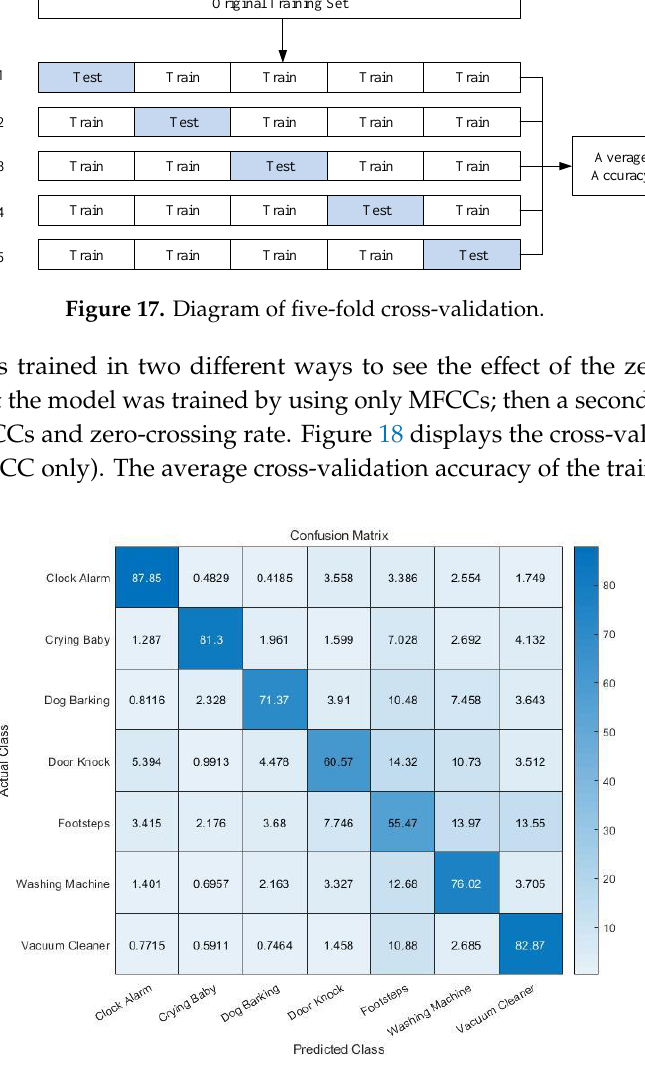
Figure 19. Five-fold cross-validation accuracy (MFCC + zero-crossing rate). A test was conducted after training a classifier. As a test set, the sound samples of the seven classes were primarily collected from YouTube. Then, the actual output sound underwent our hardware system to contain hardware dependent features. For the clock alarm sound, due to the lack of appropriate samples on YouTube, some were manually recorded. The collected sound clips were resized into 5 s long clips using a software named Audacity [40]. As a result, 10 audio clips were prepared for each class as a test set. Figure 20 shows the classification results of the test set. The numbers inside the confusion matrix simply indicates the number of audio clips which belonged to a specific cell of the confusion matrix.